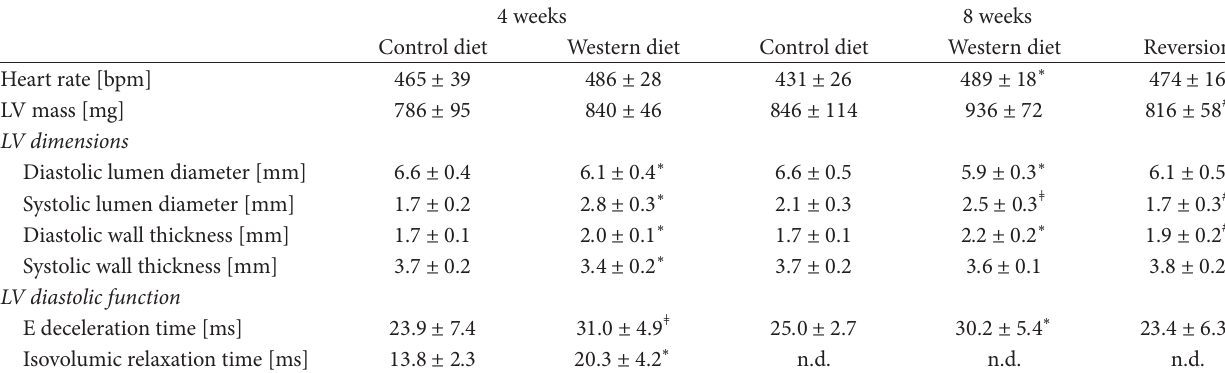
Table 2: Myocardial function after 4 and 8 weeks of diet intervention without sevoflurane